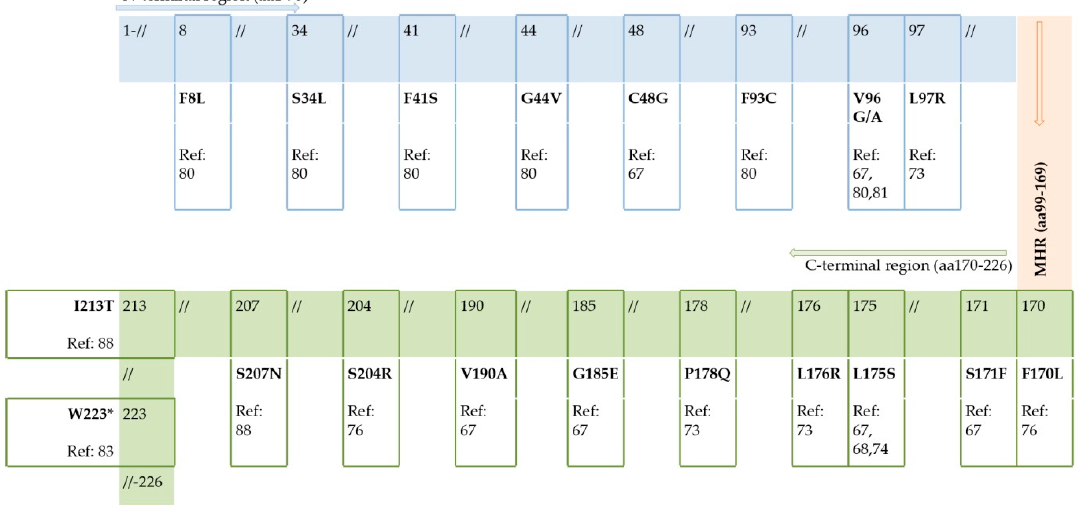
Figure 3. HBsAg mutations outside the major hydrophilic region (MHR) reported in patients su ff ering from HBV reactivation; in blue— N -terminal region of HBsAg, aa1–98; in orange—MHR, aa99–169; in green—C-terminal region of HBsAg, aa170–226; Ref—reference